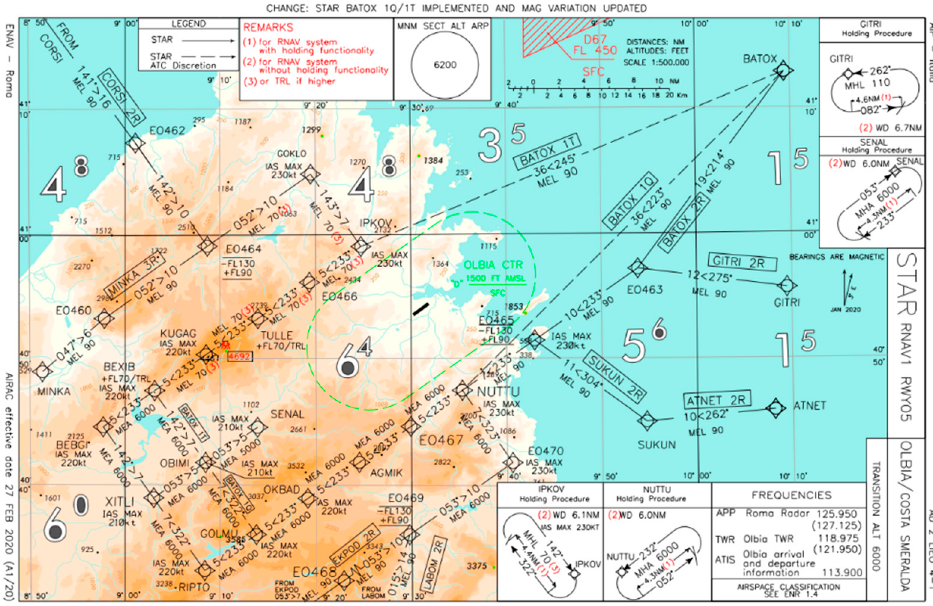
Figure 6. Trombone procedure—Costa Smeralda, OLBIA—STAR RNAV1 RWY 05 [53].